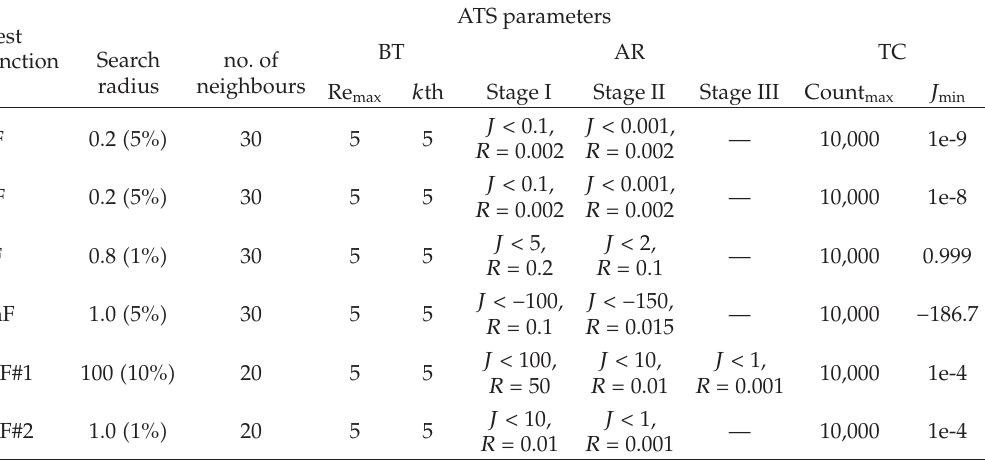
Table 2: Setting of the ATS search parameters.